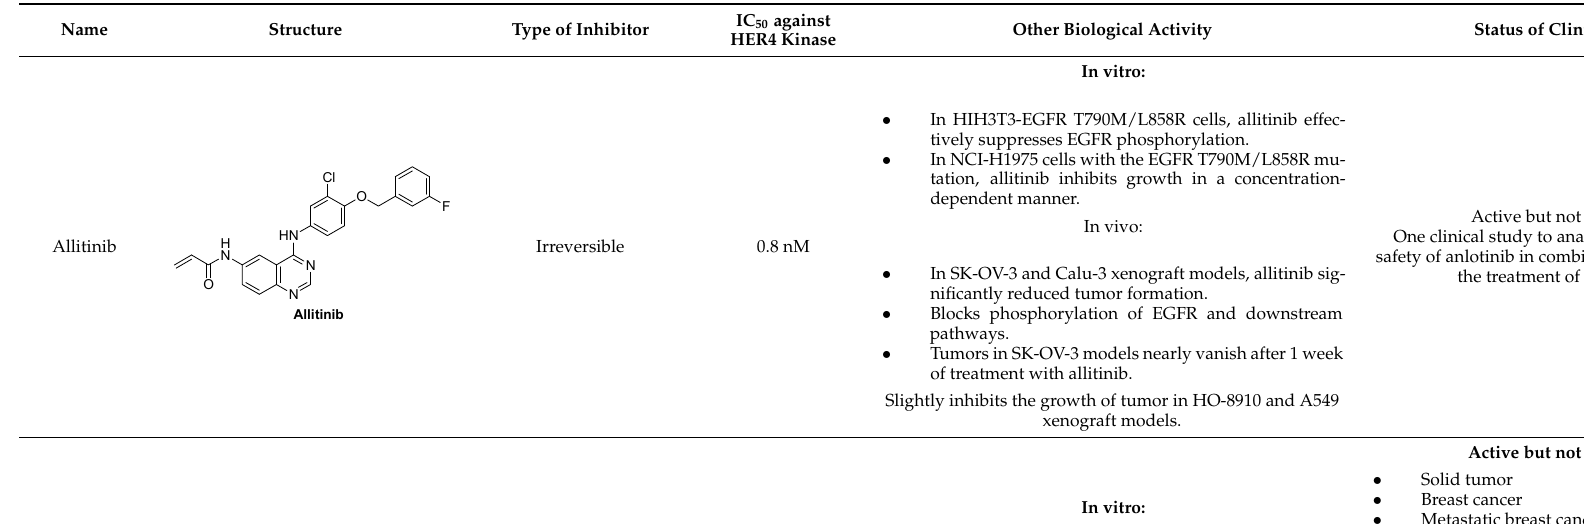
Table 1. Structures, potency, biological activities, and clinical trials (if any) of the reported HER4 inhibitors.